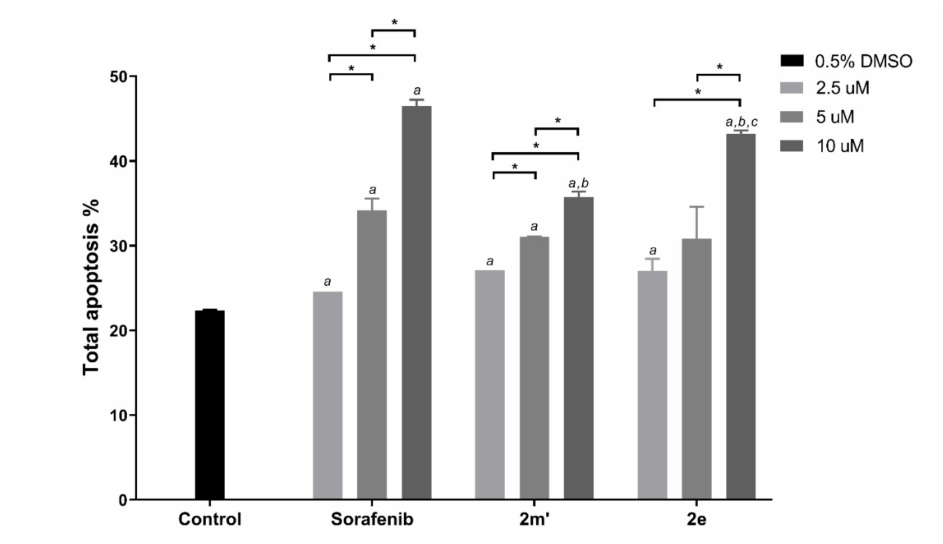
Figure 6. The comparison of the concentration-dependent total apoptosis of compounds 2m’ and 2e at 48 h, compared with 0.5% DMSO as control and Sorafenib. Each treated group was compared using Student’s t -test (* p < 0.05 was considered statistically significant; a = compared with the control group, b = compared with the 10.0 µ M Sorafenib group, c = compared with the 10.0 µ M 2m’ group).